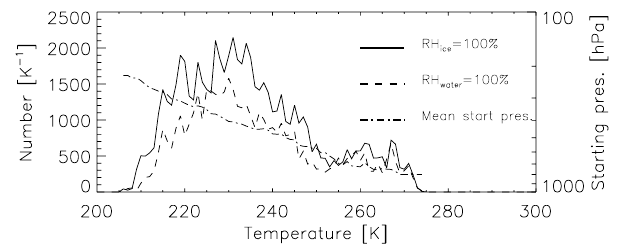
Fig. 9. The number of trajectories reaching ice or water saturation at a particular temperature (dashed and solid lines, respectively), along with the mean starting pressure of the trajectories which reached ice saturation at each temperature (dot dashed line).